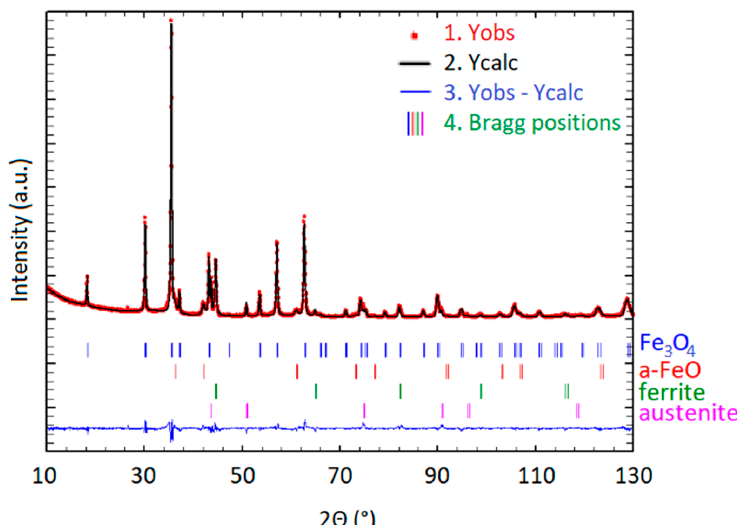
Table 1. Data of the Rietveld analysis performed on XRD profile of the studied material. Figure 1. X-ray diffraction (XRD) pattern with the Rietveld refinement results. Red circles indicate measured data points, the black line represents the calculated pattern, and the green line is the difference curve. The red, blue, green, and purple vertical lines below the data points indicate Bragg positions for the magnetite, α -FeO, α -Fe, and γ -Fe peaks, respectively.